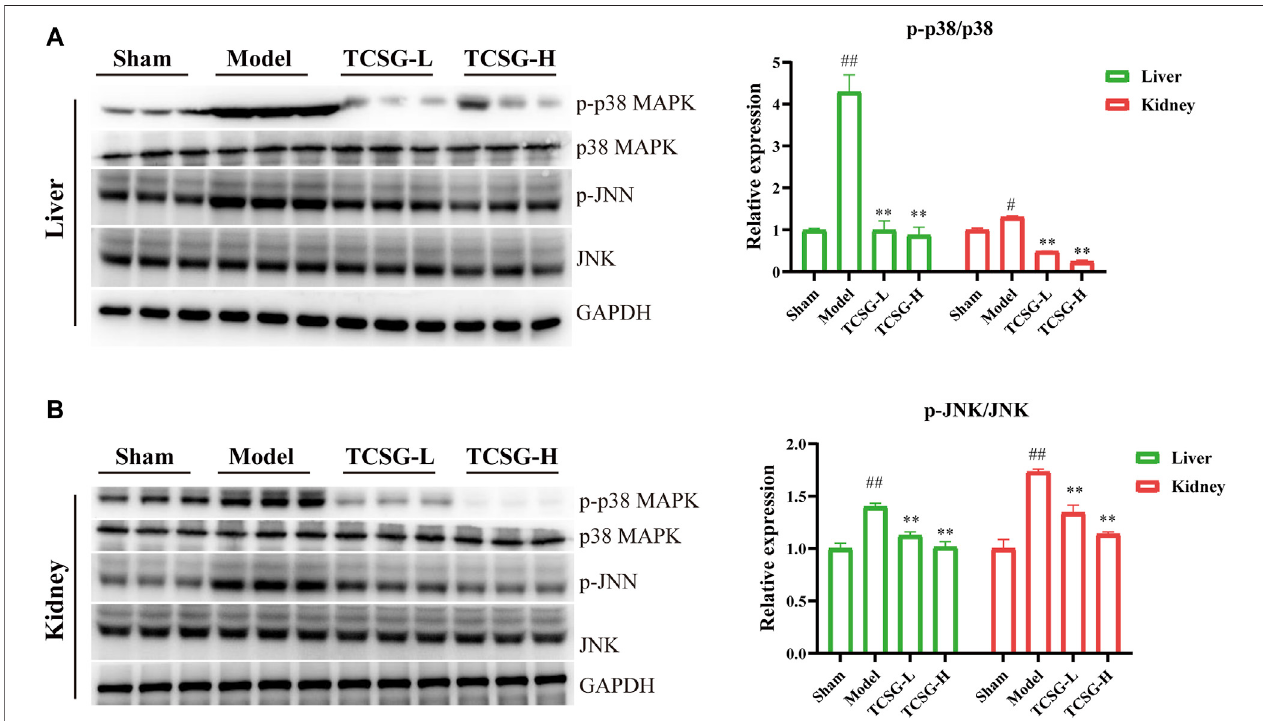
FIGURE6| TCSGfrom Baishouwu repressedp38MAPK/JNKsignalingintheliverandkidney. (A) Westernblotandquantitativeanalysisofp38MAPKandp-JNK expression in the liver. (B) Western blot and quantitative analysis of p38 MAPK and p-JNK expression in the kidney. Data are shown as means ± SEM ( n (cid:1) 3), # p < 0.05, ## p < 0.01, signi fi cantly different from sham group; ** p < 0.01, signi fi cantly different from model